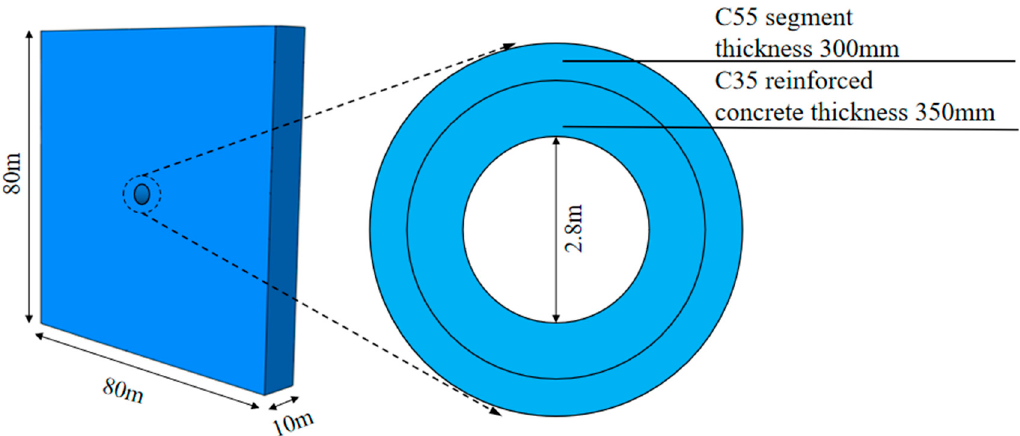
Figure 11. Overview of numerical simulation.